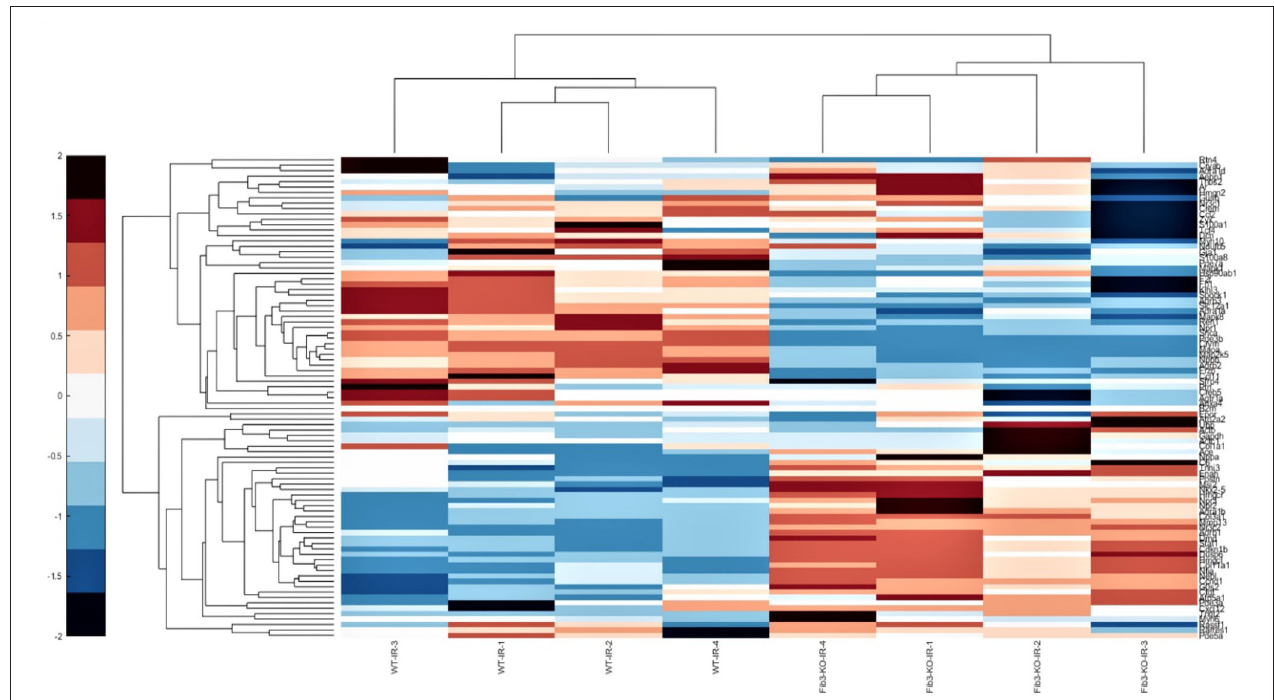
FIGURE 7 | Changes in cardiac remodeling genes in WT and Fib-3 KO CSs following I/R injury. Relative expression of Ace, Mmp13 and Ren1 in WT and Fib-3 KO CSs. Two-way ANOVA with Sidak’s multiple comparison test, p > 0.05 = ns and p < 0.0001 = ****. Error bars represent the mean ± SD ( n = 4).